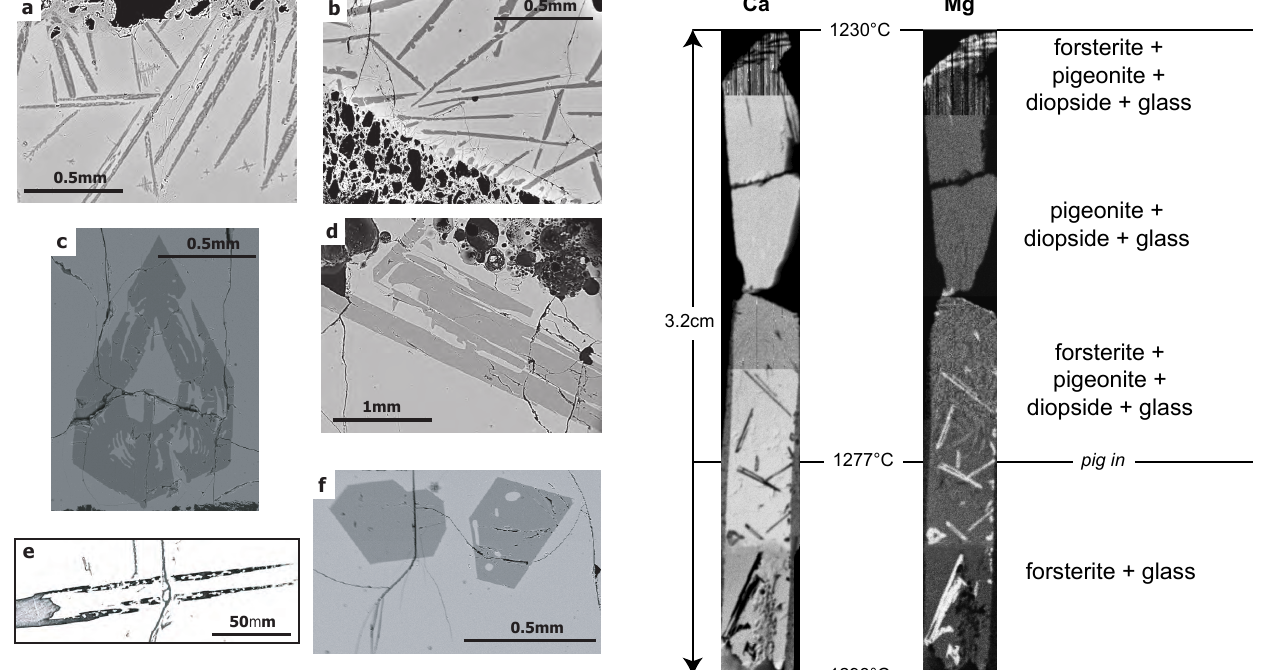
Figure 7. Microfluorescence images of the experimental charge la- belled CPX09. Indicated temperatures are quenching Fig. 7. Microfluorescence images of the experimental charge labelled CPX09. Indicated temperatures are quenched temperatures.